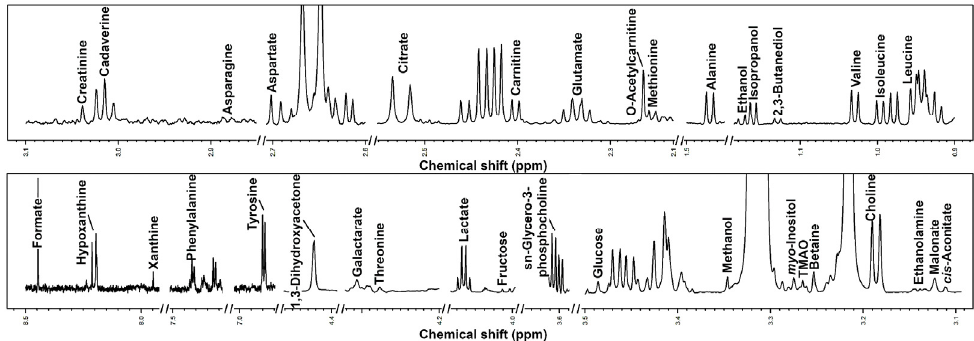
Figure 1. 1 H-NMR spectrum of giant panda seminal plasma, representative of those registered in the present work. The name of each molecule appears over the signal used for its quantification. To ease the reader’s visual inspection, for each portion, a spectrum with a convenient signal-to-noise ratio has been selected. Table 2. Molecule concentrations (mmol/L, means ± standard deviations) in different groups of gi- ant panda seminal plasma.